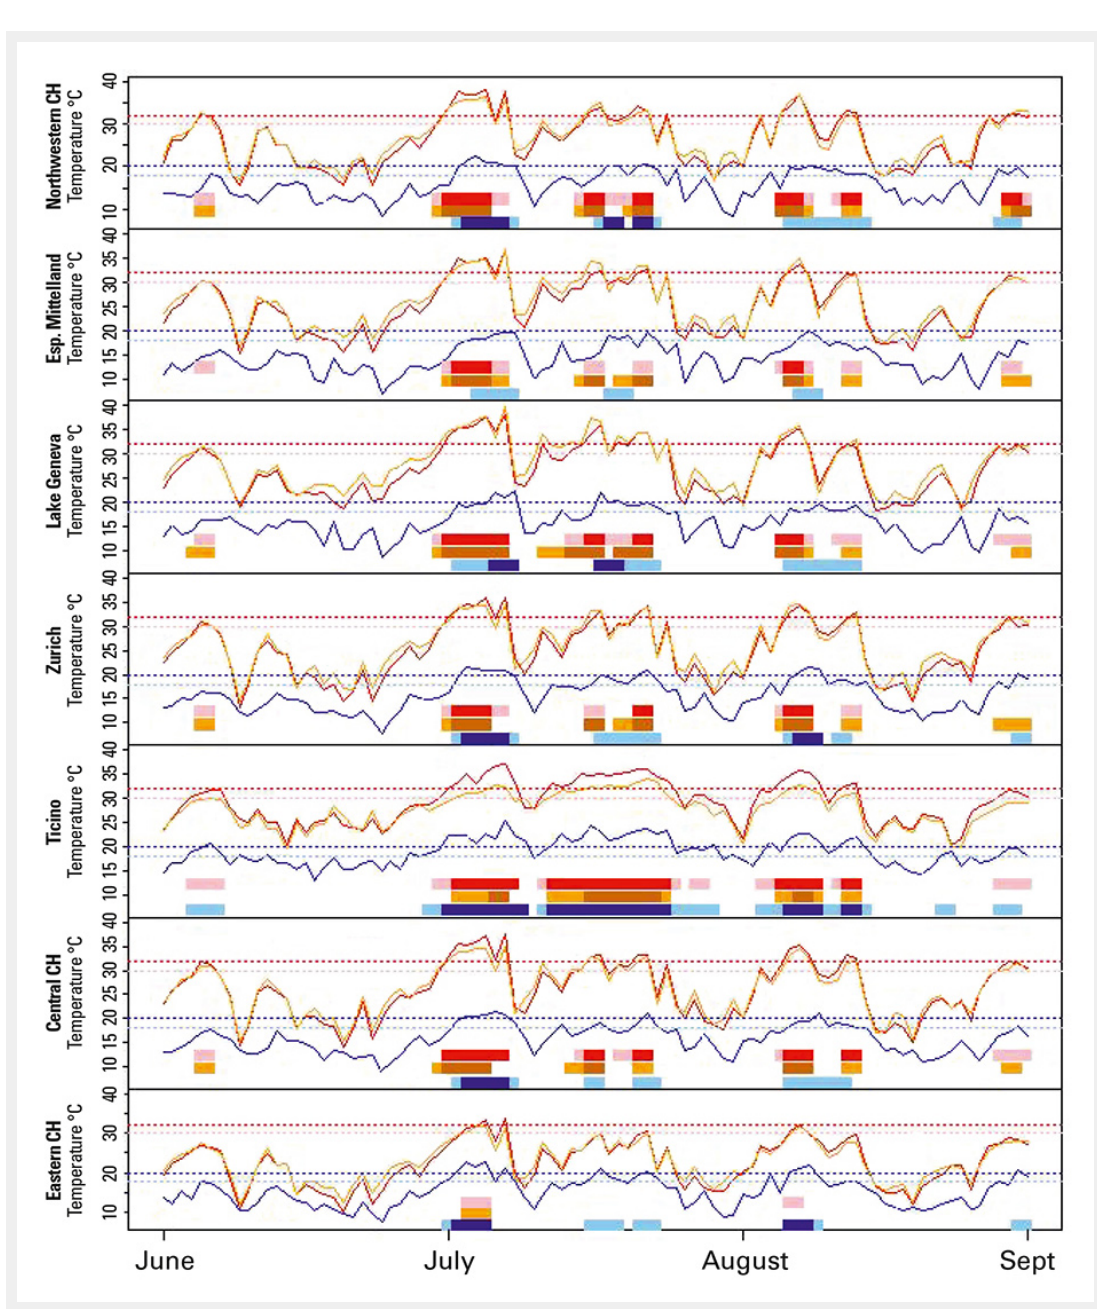
Figure 1 Daily maximum apparent (red line), daytime maximum (orange line) and night-time minimum (blue line) temperatures in each Swiss region. Horizontal bars indicating the heatwave days of at least 2 days’ length identified according to the three temperature indicators and two different thresholds. Horizontal dashed lines correspond to the temperature thresholds used for the heatwave (at least 2 consecutive days) identification (dark red/orange, 32 °C; light red/orange, 30 °C; dark blue, 20 °C; light blue, 18